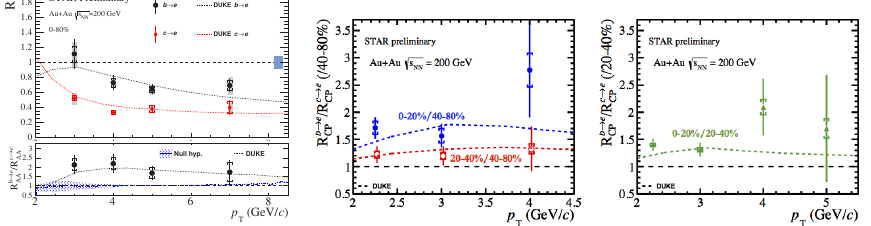
/ R c → e and R c → e (top) and the R b → e ratio (bottom) as a function of p T in 0-80% Figure 2. Left: R b → e AA AA AA AA = 200 GeV. The blue shaded curve represents the null hypothesis. Middle: Au + Au collisions at √ s NN the double ratios of R b → e to R c → e (0-20% / 40-80% and 20-40% / 40-80%) as a function of p T . Right: the CP CP double ratio of R b → e to R c → e (0-20% / 20-40%) as a function of p T . Results are compared to the Duke CP CP model calculations.